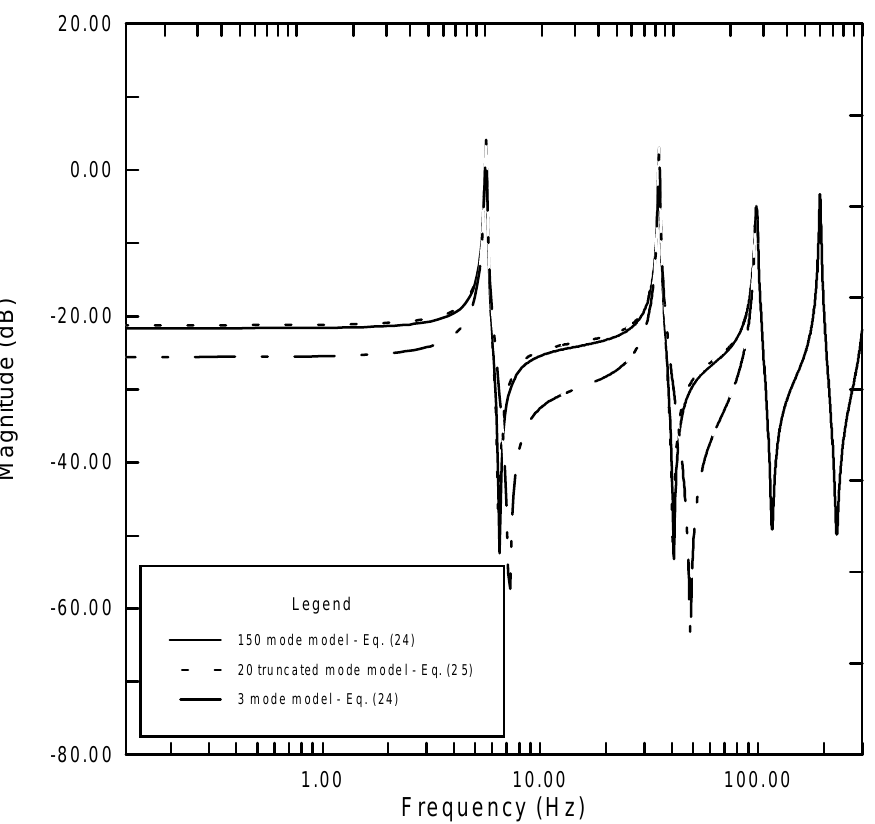
Fig. 10. Comparison of the transfer functions of the 150 mode model, 20 truncated mode model, and the 3 mode model of the flexible beam. Q c = I (identity matrix). Matrices A , B and C